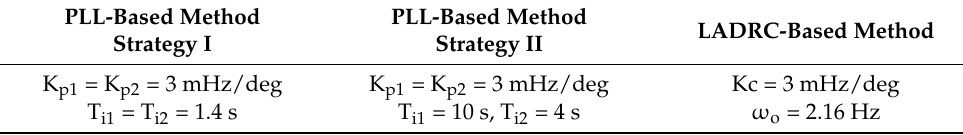
Table 1. Parameters of the Tested